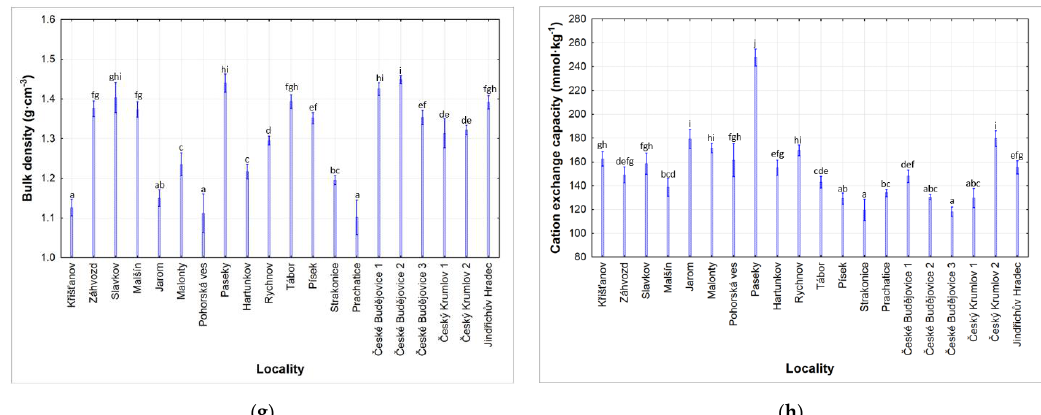
Figure 1. Analyses of samples of clay Cambisols (ANOVA, p < 0.00001): ( a ) pH KCl (F (19, 100) = 161.38); ( b ) particles < 0.01 mm (F (19, 100) = 48.726); ( c ) C org (F (19, 100) = 111.06); ( d ) maximal capillary capacity (F (19, 100) = 1136.8); ( e ) degree of sorption saturation (F (19, 100) = 535.19); ( f ) specific weight (F (19, 100) = 24.979); ( g ) bulk density (F (19, 100) = 143.02); ( h ) cation exchange capacity (F (19, 100) = 118.67); significant differences between localities are shown in letters (Tukey’s honest significance test; p = 0.05). Note: C org — soil organic carbon (%).